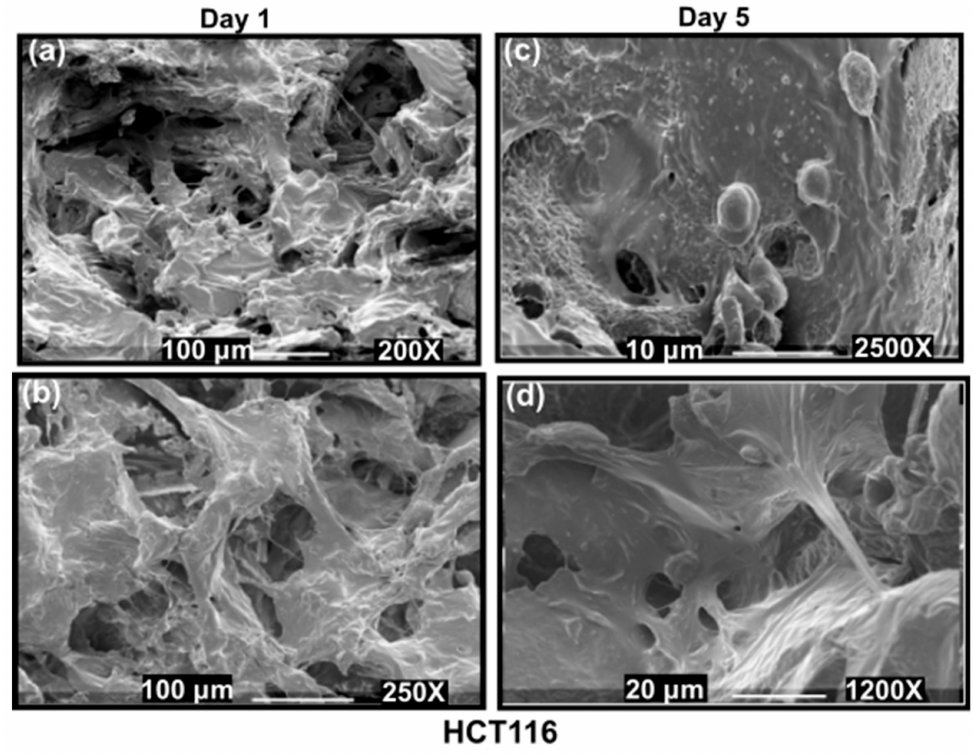
Figure 3. SEM images of HCT116 cells grown on 10 mm × 10 mm × 8 mm 3D PHA scaffolds on Day 1 ( a , b ) and Day 5 ( c , d